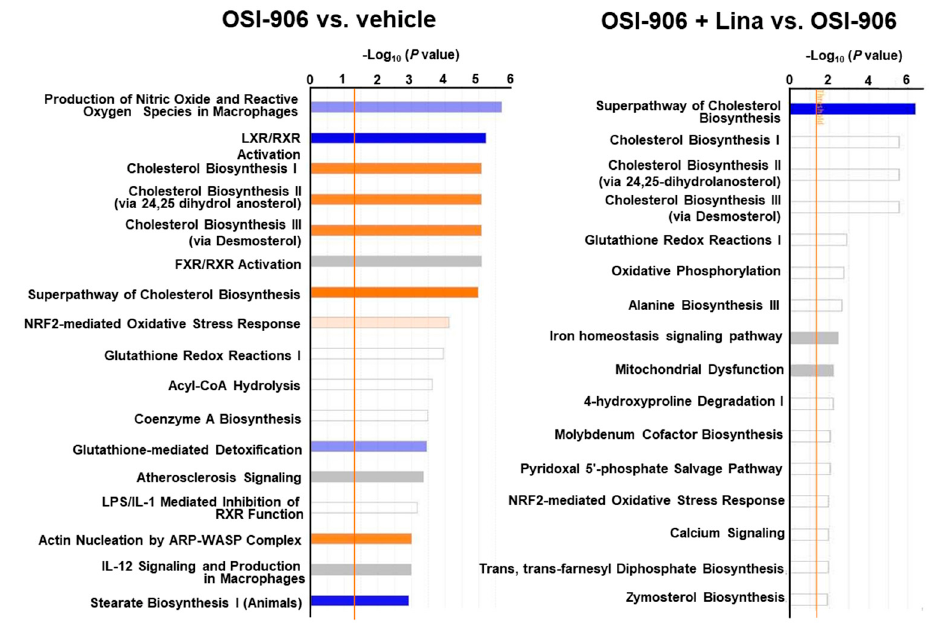
Figure 6. Canonical pathway analysis of proteomics in the livers of OSI-906- and linagliptin-treated mice. A canonical pathway analysis of the hepatic proteomic data was performed using molecules that were differentially expressed (ANOVA p < 0.05) in comparisons of OSI-906 vs. vehicle and OSI-906 + Lina vs. OSI-906. The color of the bar indicates the z-score (orange, positive z-score; blue, negative z-score). The orange line depicts the statistical significance threshold ( p = 0.05).